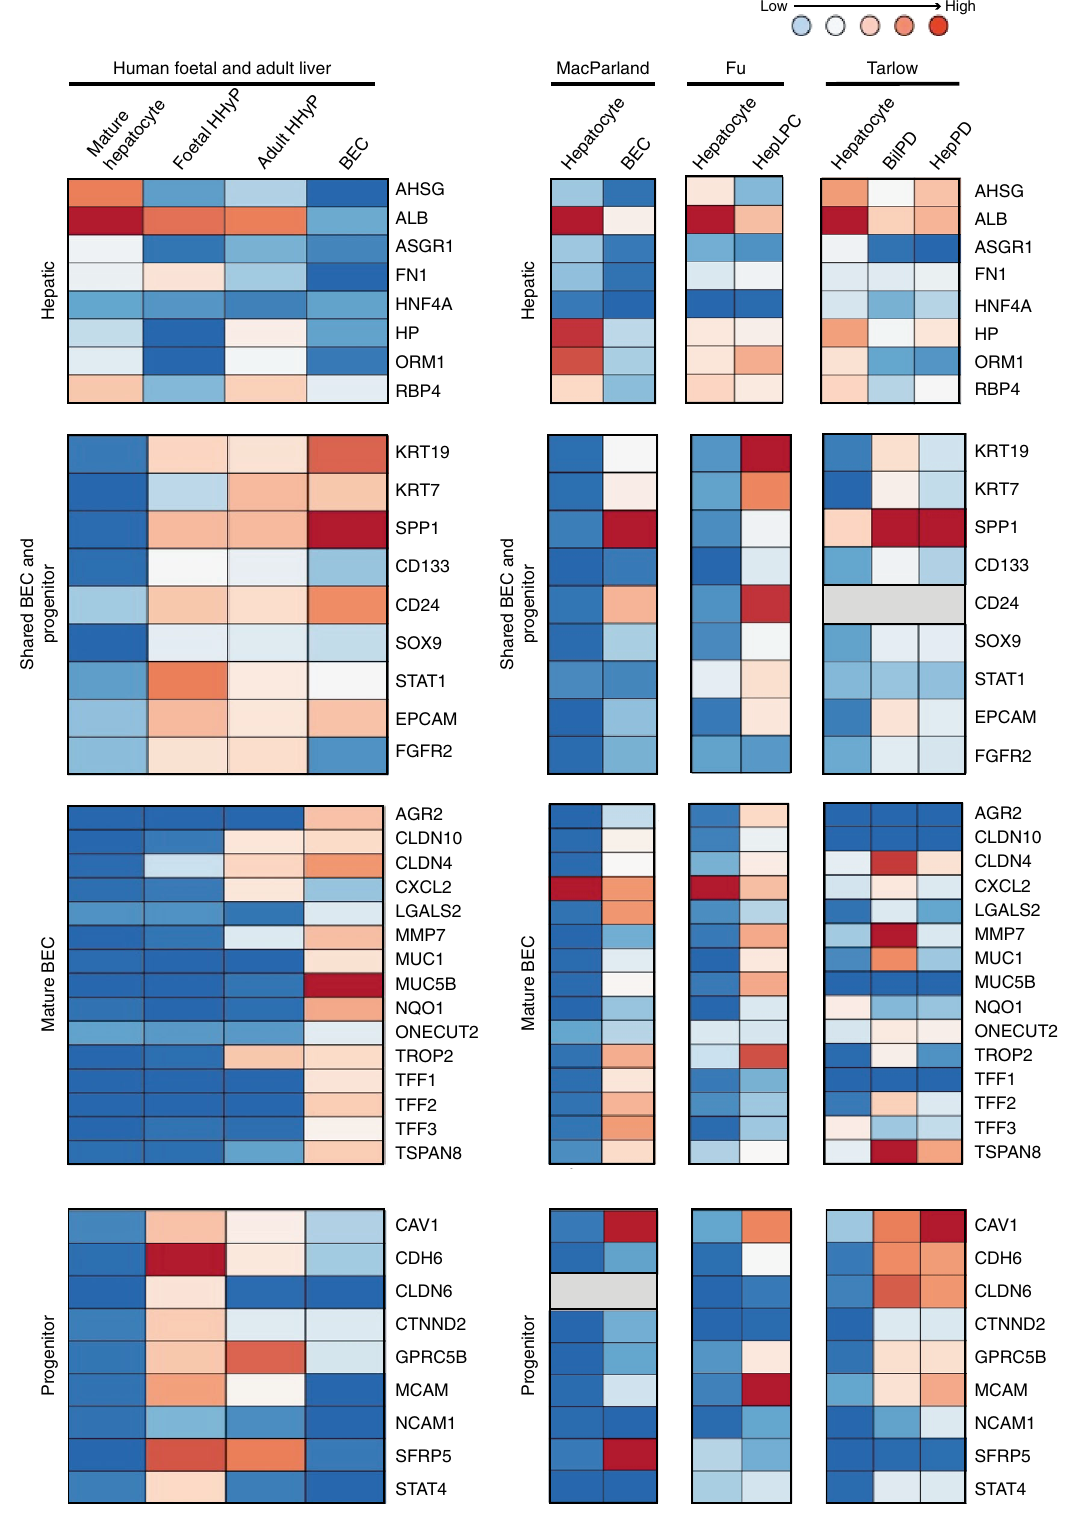
Fig. 7 Collated marker expression in hepatic progenitor populations. Heatmaps of selected marker expression in populations identi fi ed in this study with different cohorts of liver progenitor-like cells, biliary epithelial cells (BECs) and primary hepatocytes. Shown is gene expression patterns of publicly available sequencing data from GEO (https://www.ncbi.nlm.nih.gov/geo/) or literature mined. Bulk RNA-seq data sets, include reprogrammed human hepatic liver progenitor cells (hepLPCs-Heps, GSE105019) and primary hepatocytes (pHs, GSE105019) from Fu et al. 16 and mouse